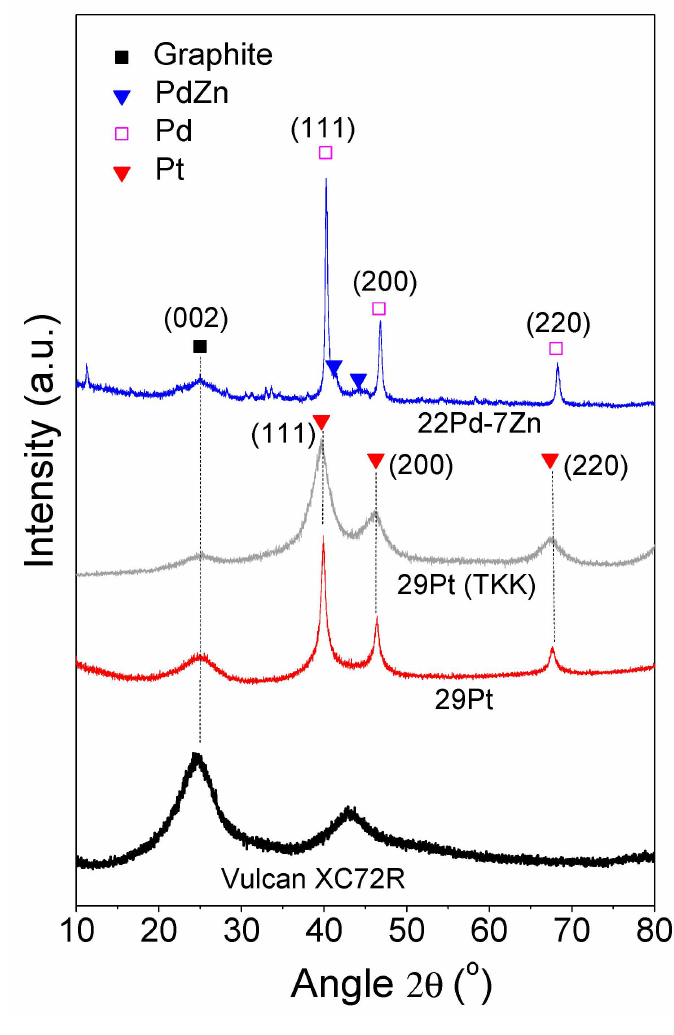
Figure 1. X-ray diffraction patterns of the tested electrocatalyst powders and of the carbon black support (Vulcan